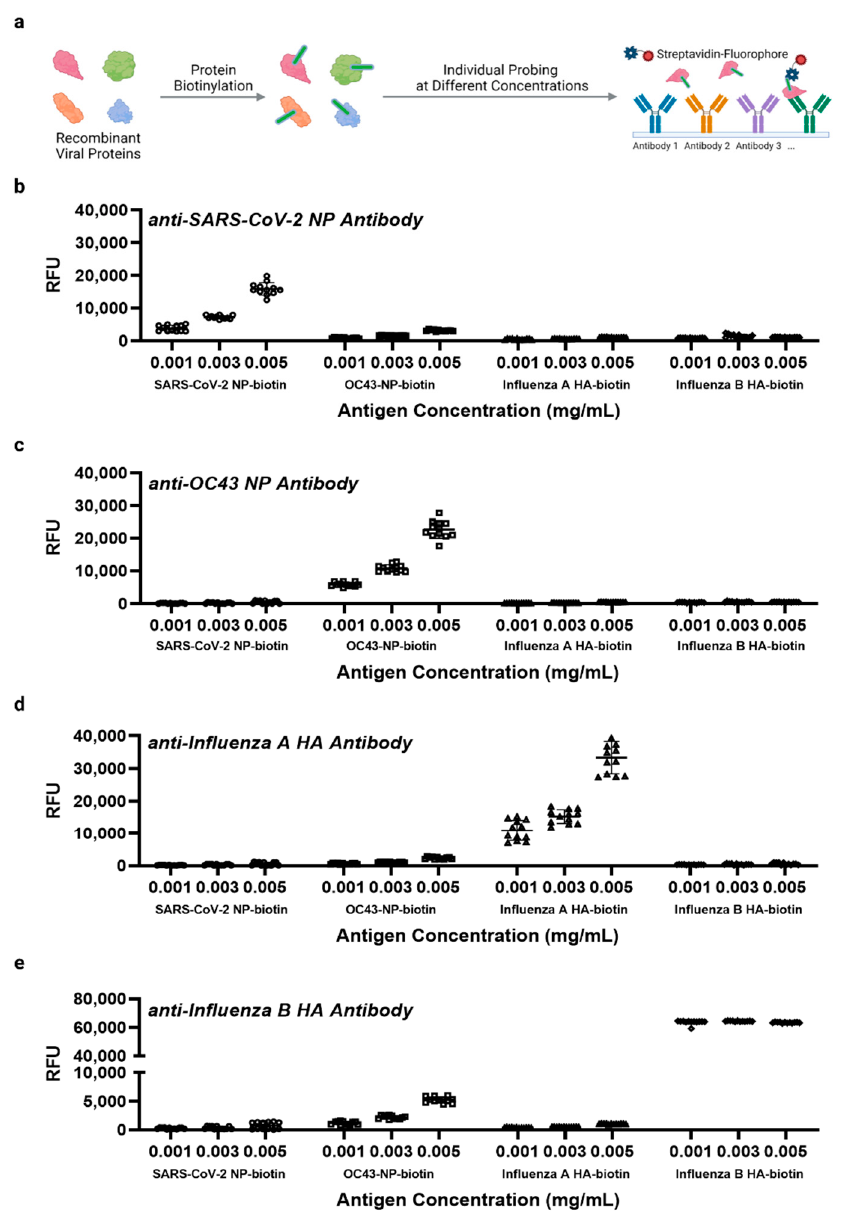
Figure 5. Detection of four recombinant viral proteins after biotinylation using the antibody microarray. On each pad, four different capture antibodies were printed with six replicates each. ( a ) Protein biotinylation and sample probing are illustrated. This panel was created with BioRender.com. Essentially, the detection scheme is identical to Figure 1e. Here, the graphs indicate RFUs from four biotinylated viral antigens detected at three different concentrations by specific capture antibodies: ( b ) anti-SARS-CoV-2 NP (reagent number 14 Table S1), ( c ) anti-OC43 NP (reagent number 18 Table S1), ( d ) anti-influenza A hemagglutinin (HA) (reagent number 16 Table S1), and ( e ) anti-influenza B HA (reagent number 17 Table S1). Two independent experiments were performed.